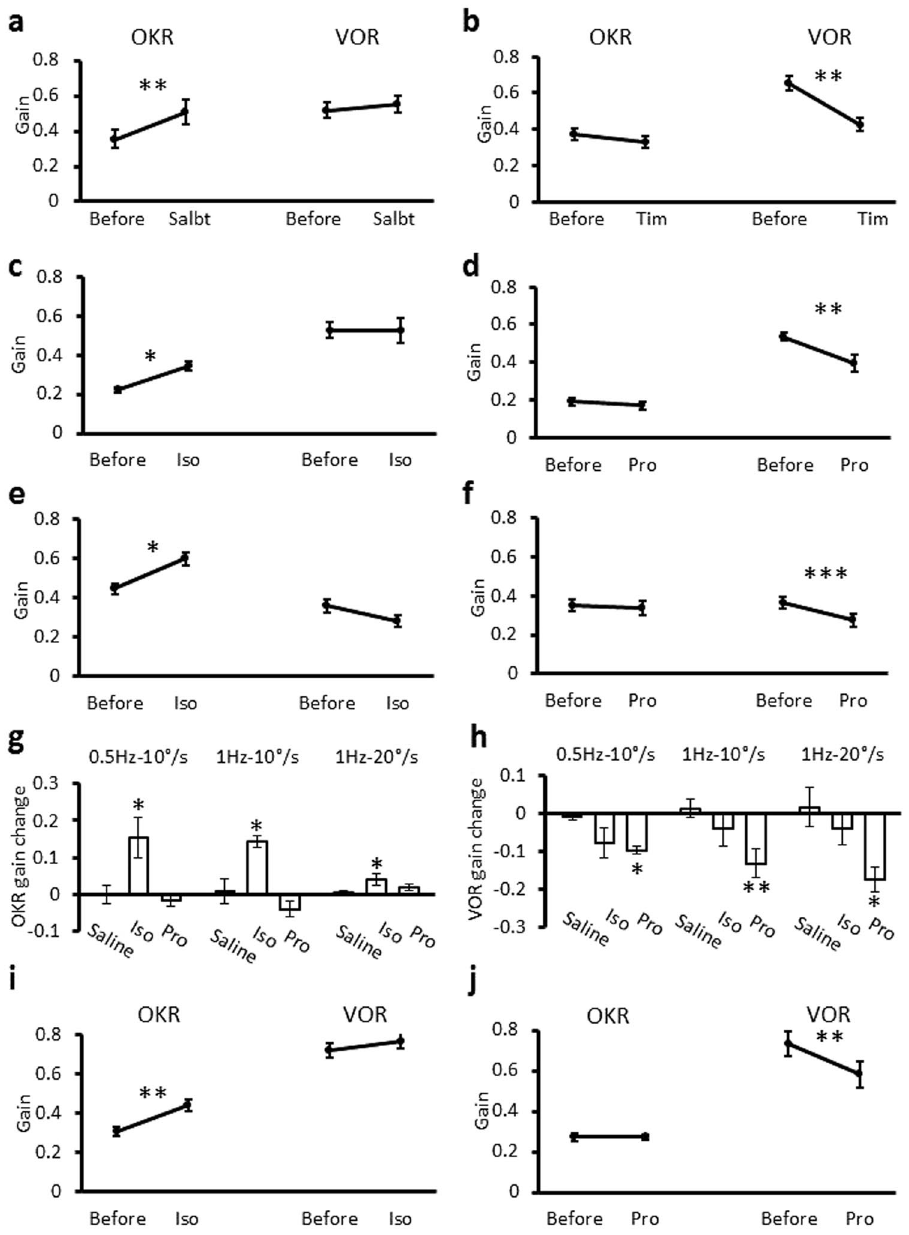
Figure 2. OKR and VOR gain changes induced by β -adrenergic agonist or antagonist in various conditions. ( a , b ) OKR and VOR gain changes induced by contralateral injection of β -adrenergic agonist salbutamol ( a ) or antagonist timolol ( b ). ( c , d ) Effects of contralateral injection of isoproterenol ( c ) or propranolol ( d ) on gains of OKR and VOR during sinusoidal rotation of the screen or the turntable at 1 Hz, 20°/sec peak velocity. ( e , f ) Effects of isoproterenol ( e ) or propranolol ( f ) injection on gains of OKR and VOR during sinusoidal rotation of the screen or the turntable at 0.5 Hz, 10°/sec peak velocity. * p < 0.05, ** p < 0.01, *** p < 0.001, paired Student’s t-test. ( g , h ) Gain changes of OKR ( g ) and VOR ( h ) induced by administration of saline, isoproterenol or propranolol under different rotation conditions. * p < 0.05, ** p < 0.01, compared with saline-injected control, Dunnett’s test. ( i , j ) OKR and VOR gain changes induced by ipsilateral injection of isoproterenol ( i ) or propranolol ( j ). ** p < 0.01, paired Student’s t-test. Error bars indicate